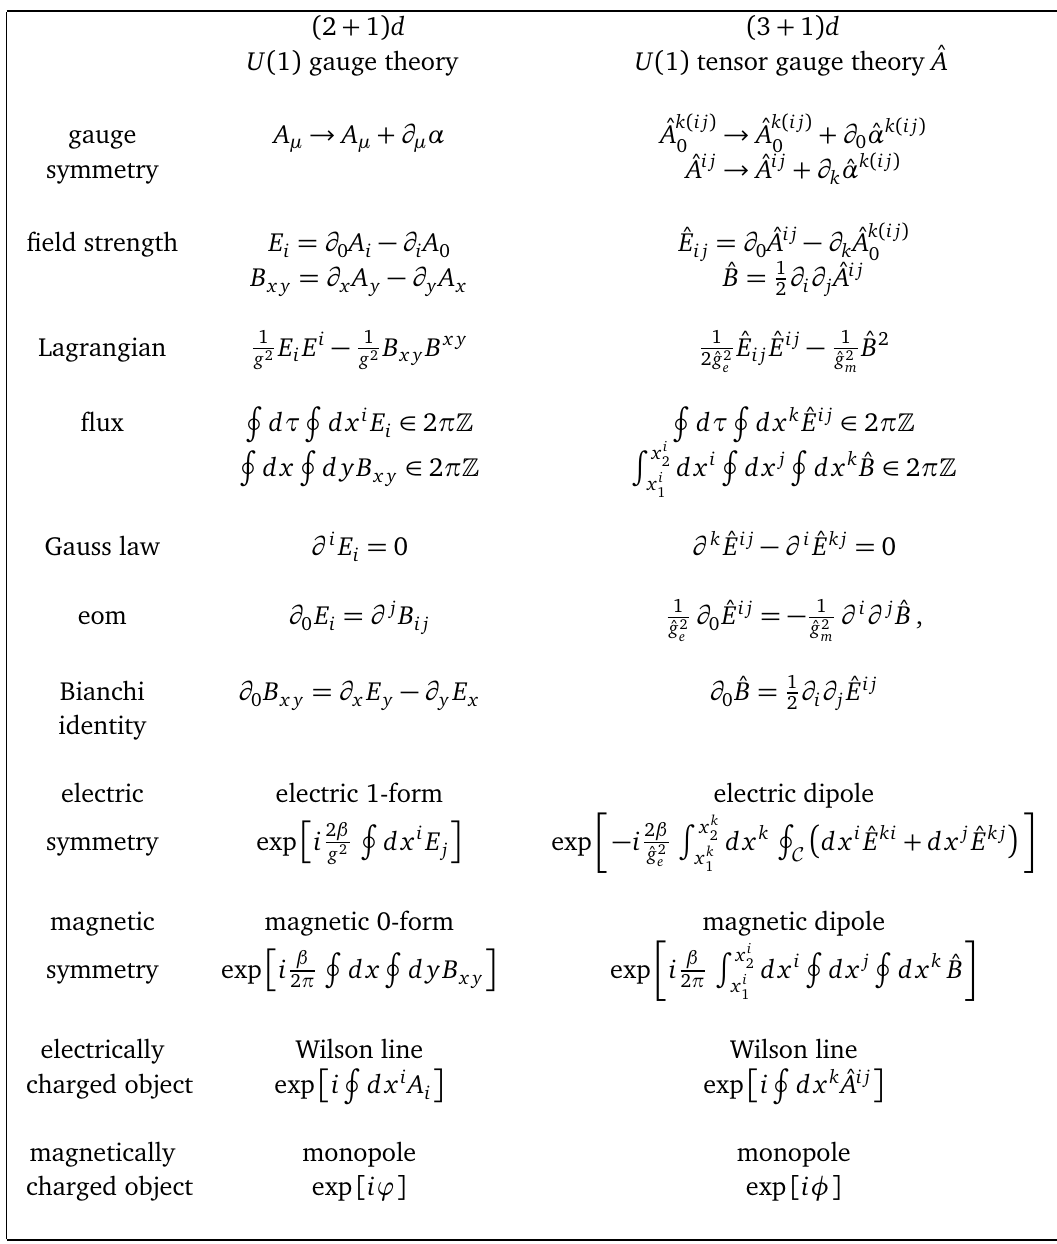
Table 6: Analogy between the 3 + 1-dimensional U ( 1 ) tensor gauge theory ˆ A and the ordinary 2 + 1-dimensional U ( 1 ) gauge